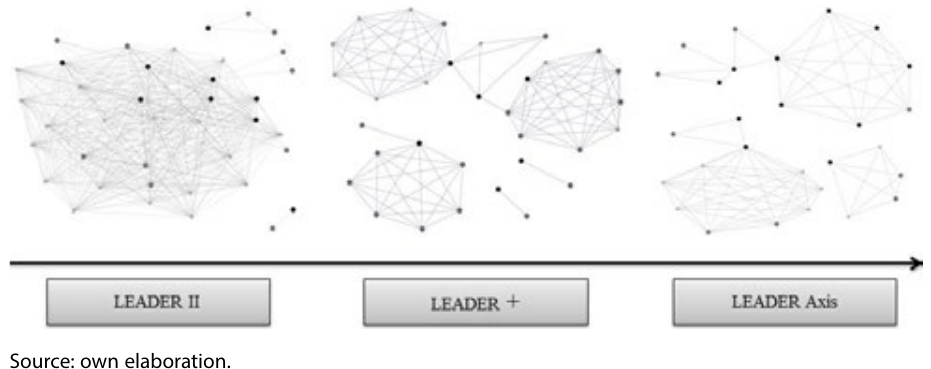
Source: own elaboration.